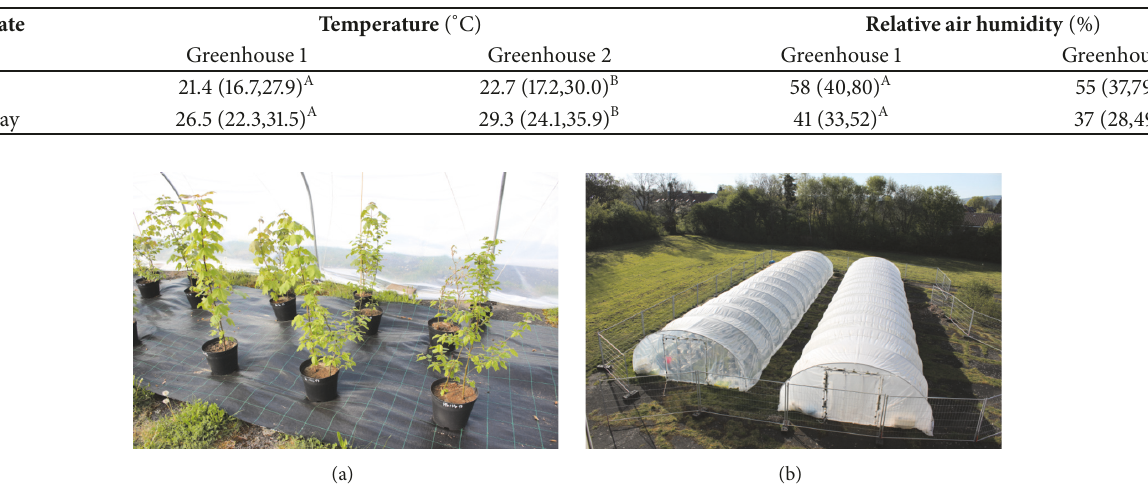
Figure 1: Experimental study with the (a) trail pots harbouring Fagus sylvatica , Acer pseudoplatanus , and Carpinus betulus tree individuals (b) in greenhouses 1 (left) and 2 (right) at the installation site at the Samelsonplatz, Hildesheim.